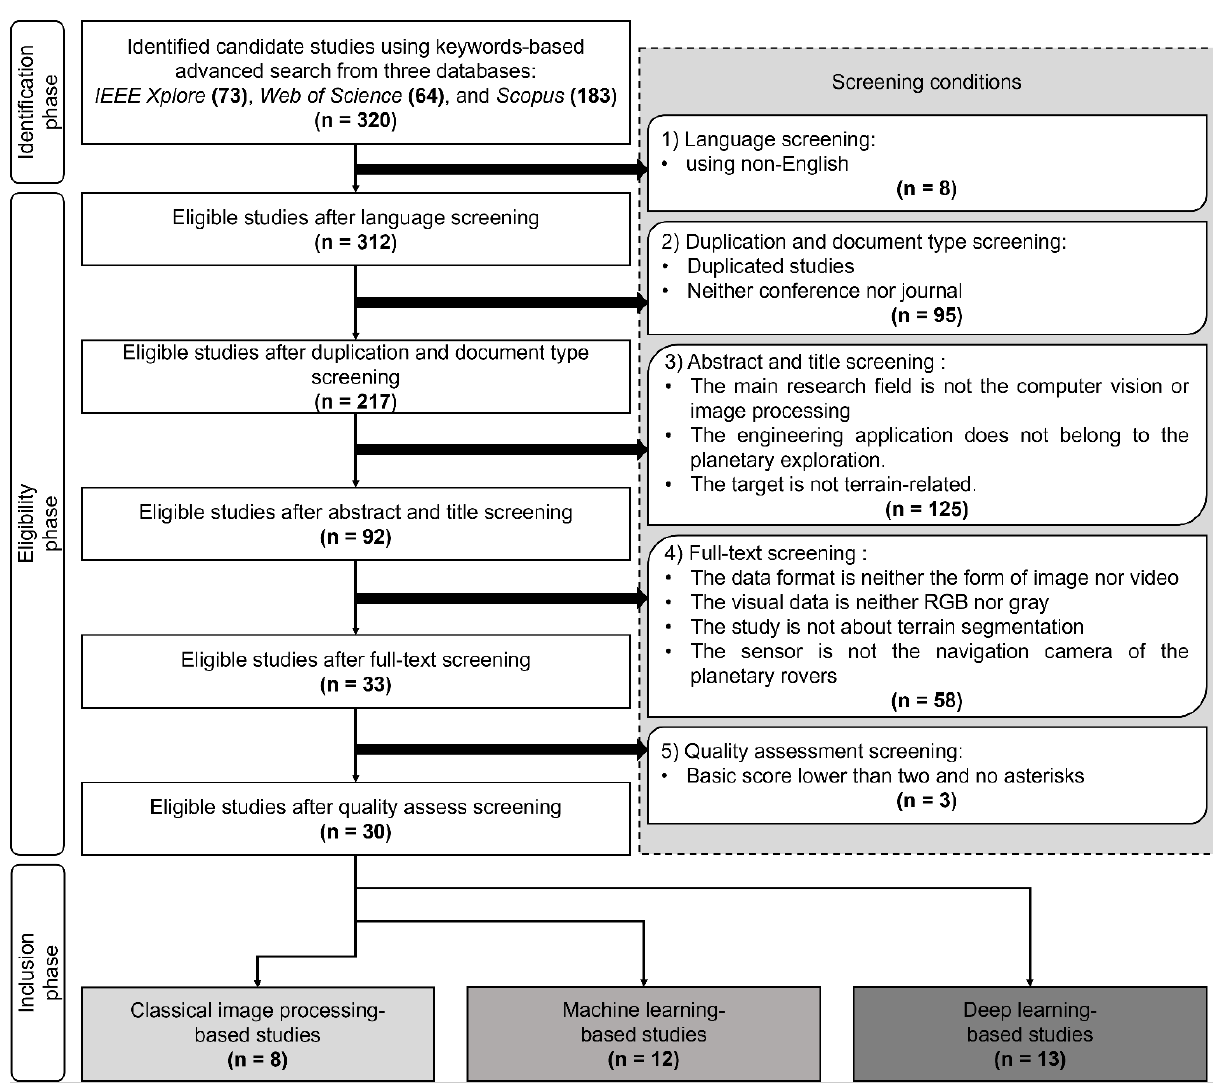
Figure 1. The flow diagram of this systematic literature review. The search process has been separated into three phases, “ Identification phase ” , “ Eligibility phase ” , and “ Inclusion phase ” . The screening follows the inclusion and exclusion criteria depicts in Section 2.3. The “n” in each frame refers to the number of studies for the corresponding action or category.